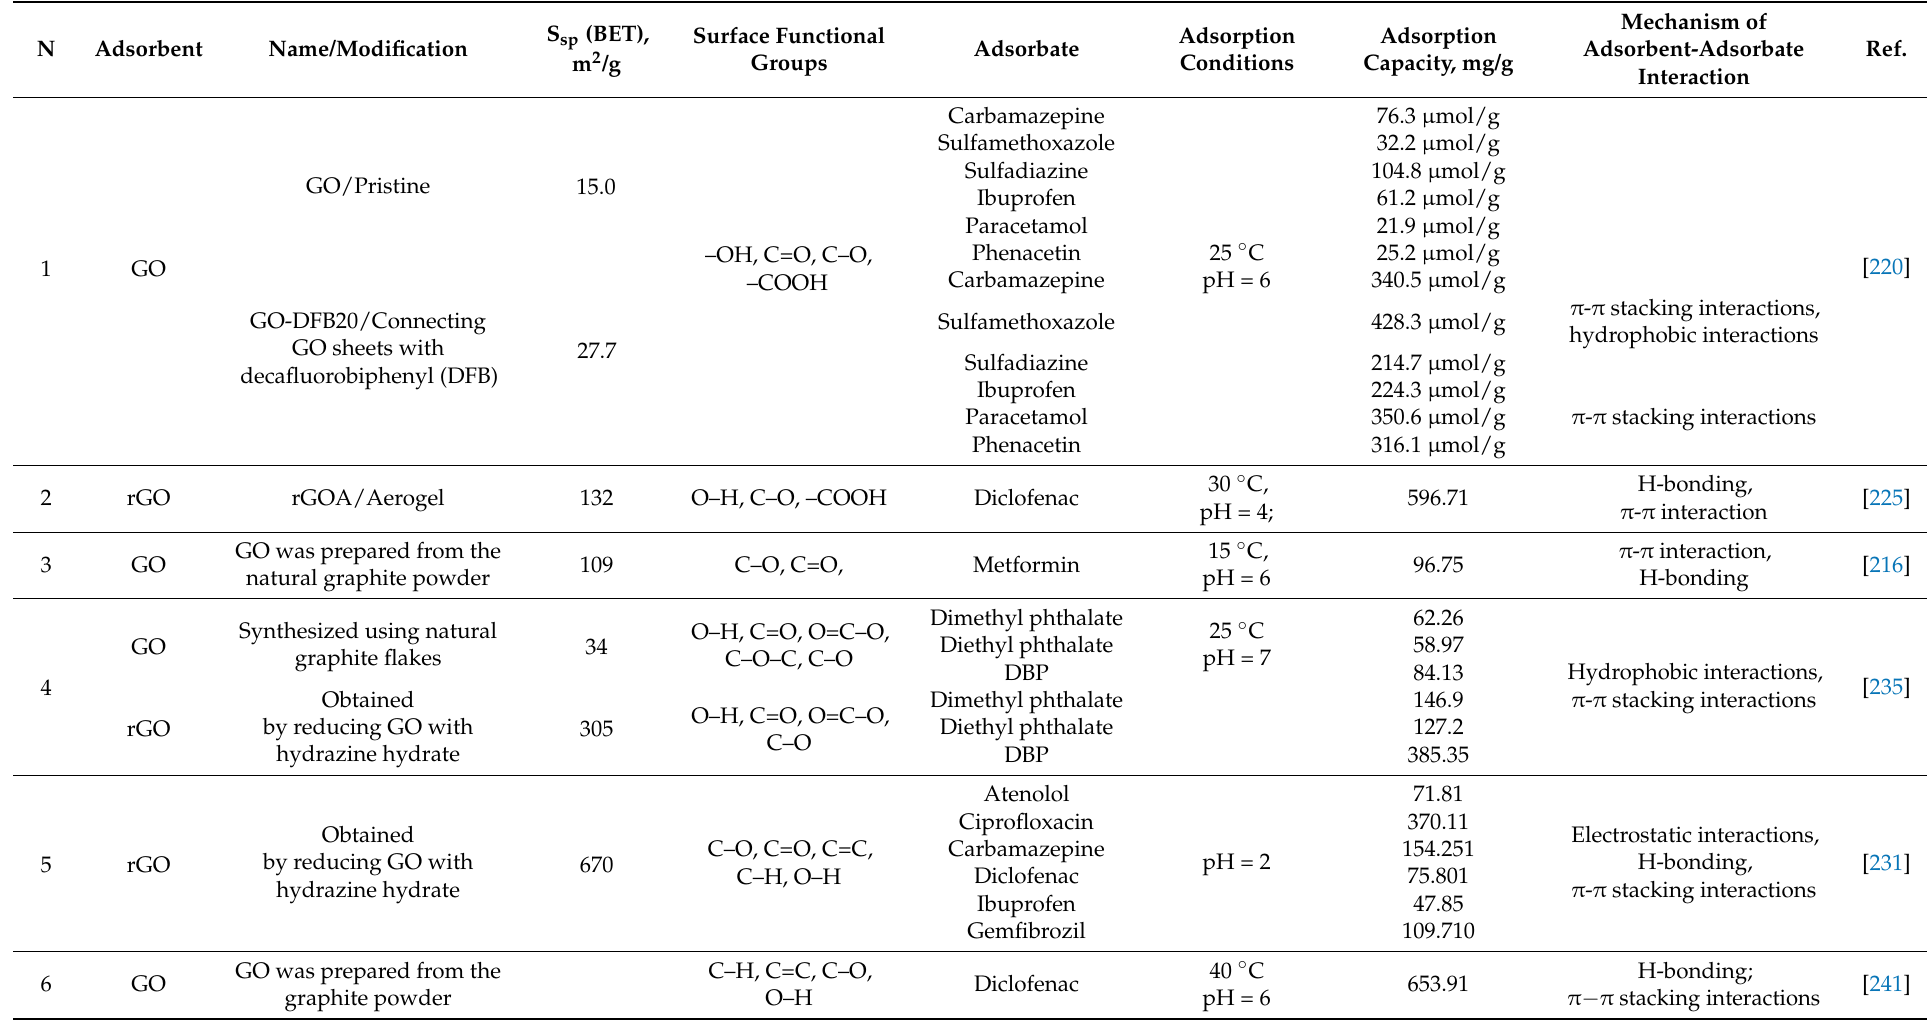
Table 2. Surface characteristics, adsorption capacity and mechanism of adsorption on graphene oxide for various